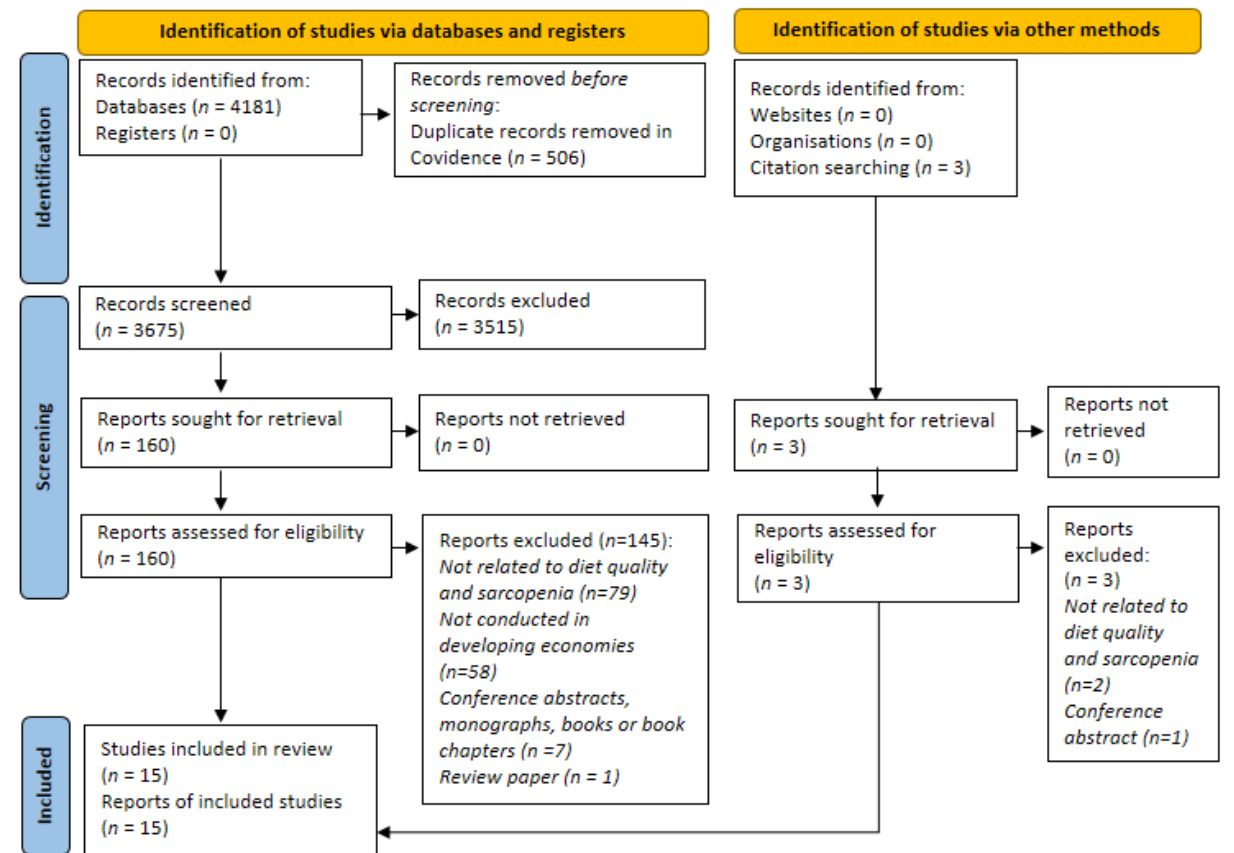
Figure 1. PRISMA 2020 flow chart showing the study selection process. Table 1. Characteristics of studies included in the review ( n =